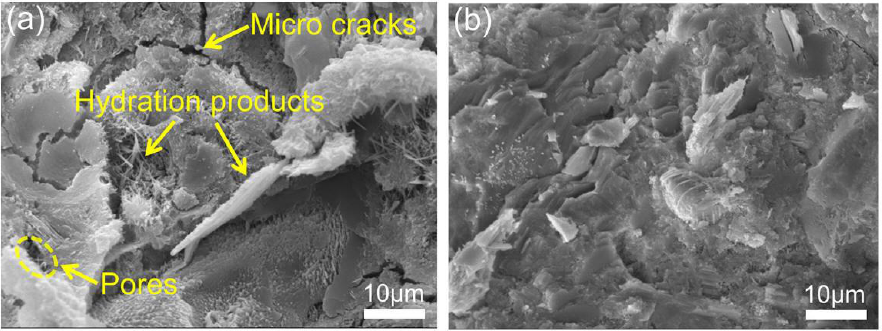
Figure 19. SEM images of cement paste after 28 days: ( a ) 0 wt% GO; ( b ) 0.6 wt% GO. Reprinted with permission from Ref. [107]. Copyright 2020 Elsevier.